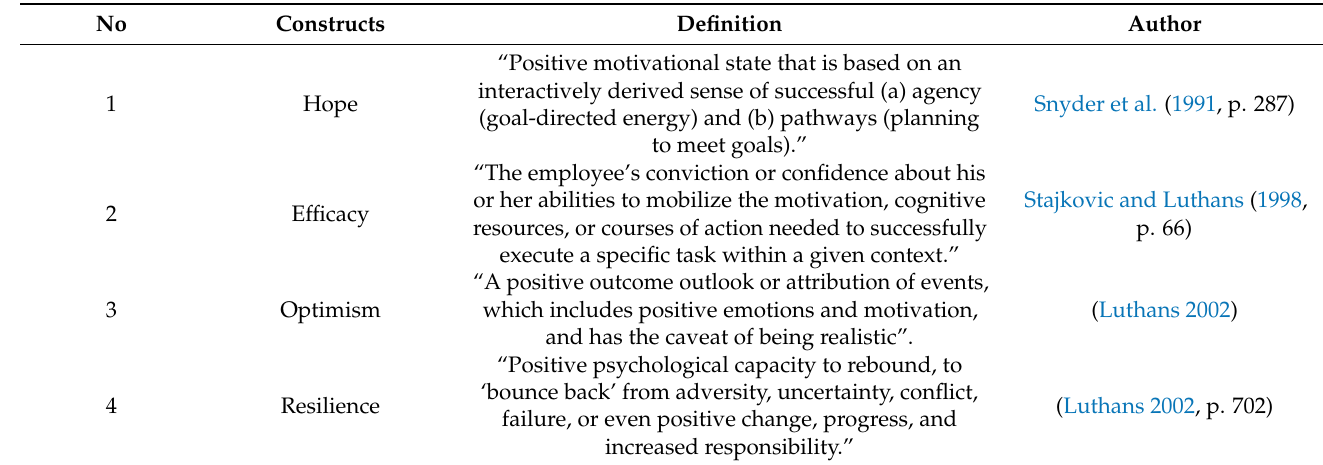
Table 1. Formative constructs of psychological capital